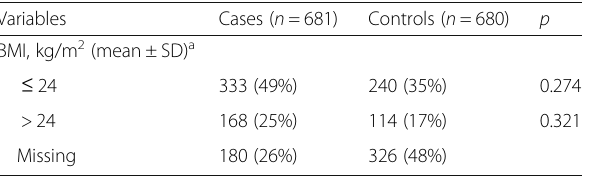
Table 1 Characteristic of breast cancer patients and health control individuals